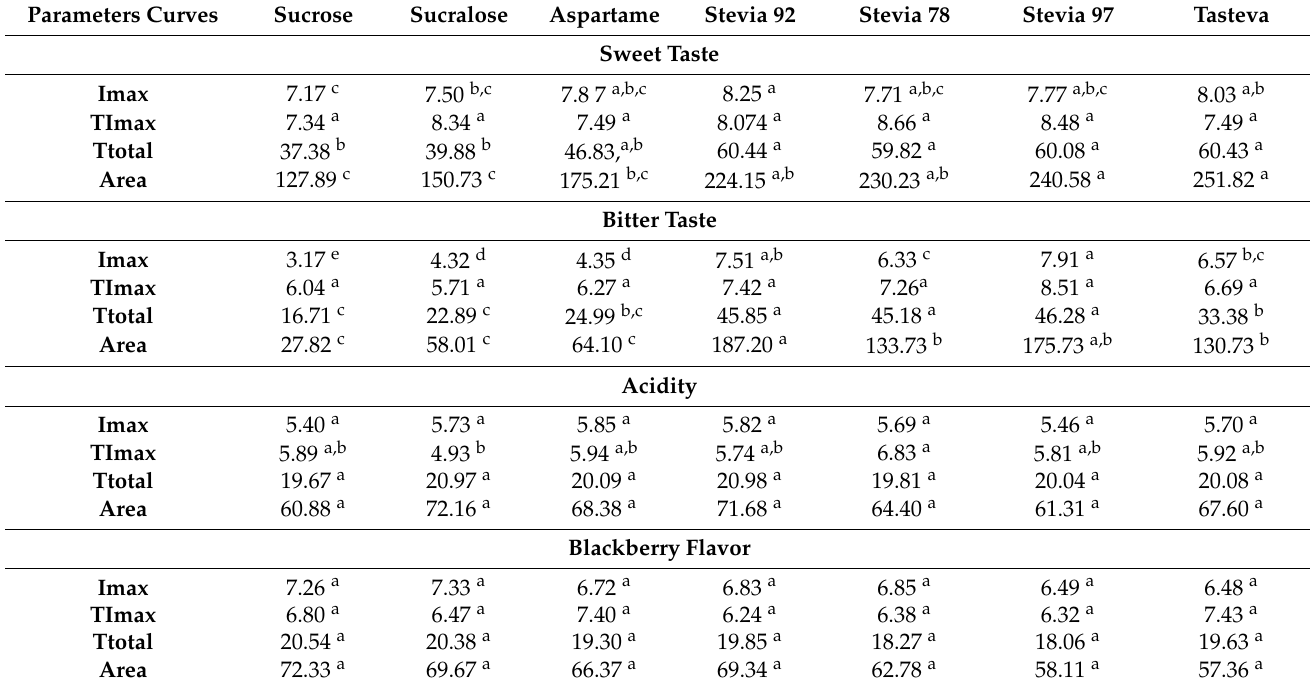
Table 4. Means * of the parameters from time-intensity curves for the sweet taste, bitter taste, acidity, and blackberry flavor to the blackberry nectar in the equi-sweet ideal